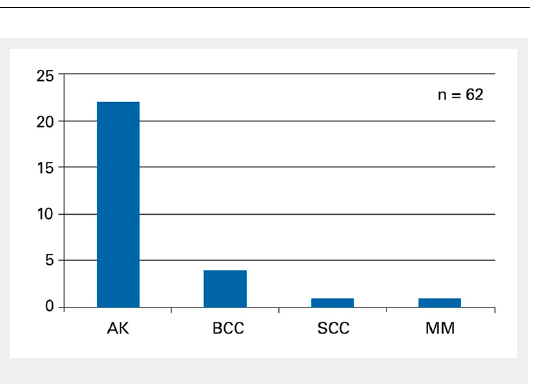
Graphical presentation of nonmelanoma skin cancer and its premalignant stages found during the full-body skin examination of all participants by a dermatologist. The size of the stars depicts the number of findings: a small star represents a single finding, a big star field